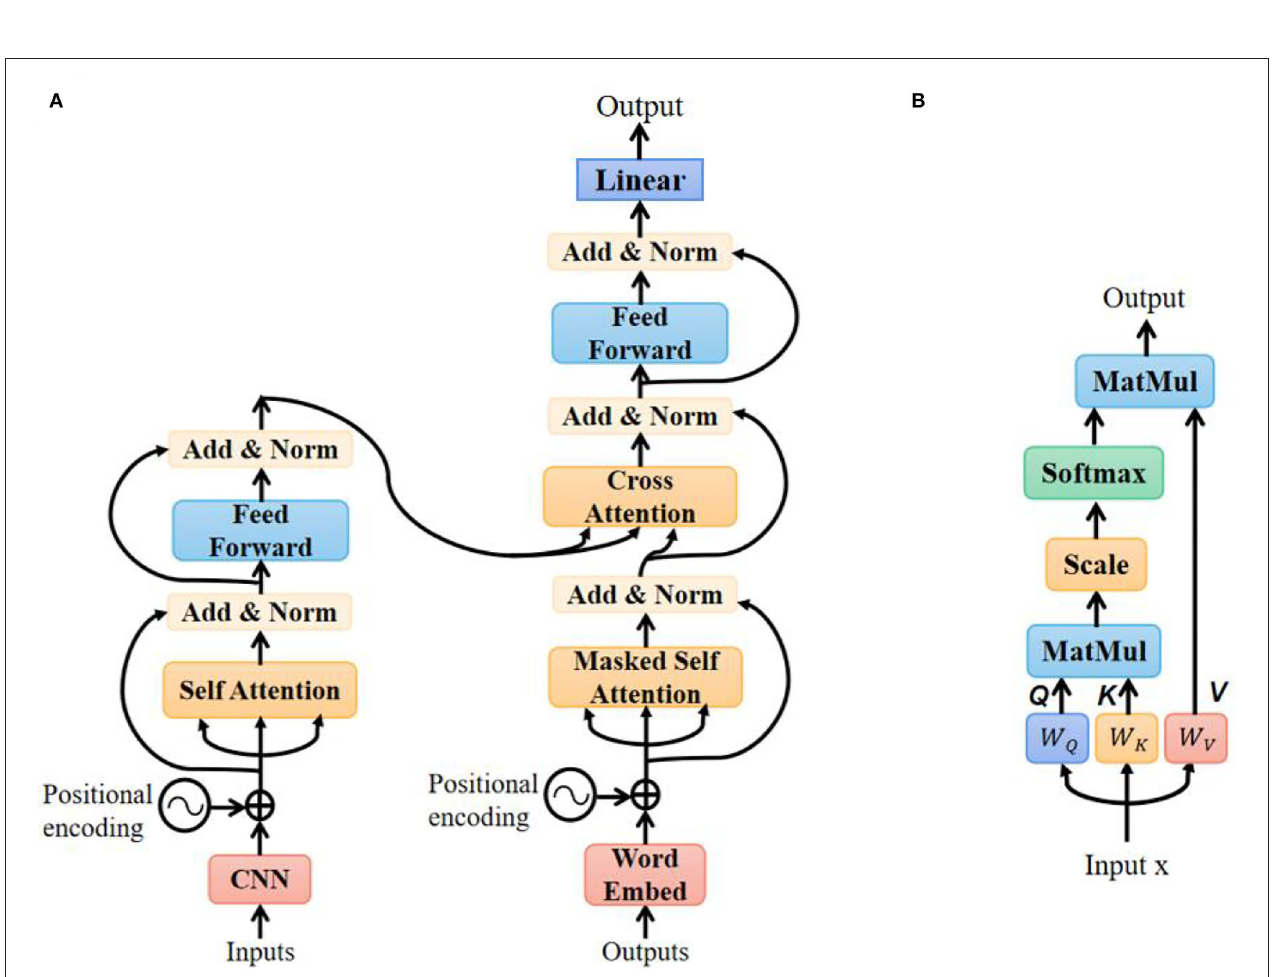
FIGURE 7 | Transformer-based translation model: (A) architecture of the model; (B) detailed structure of the self-attention layer.